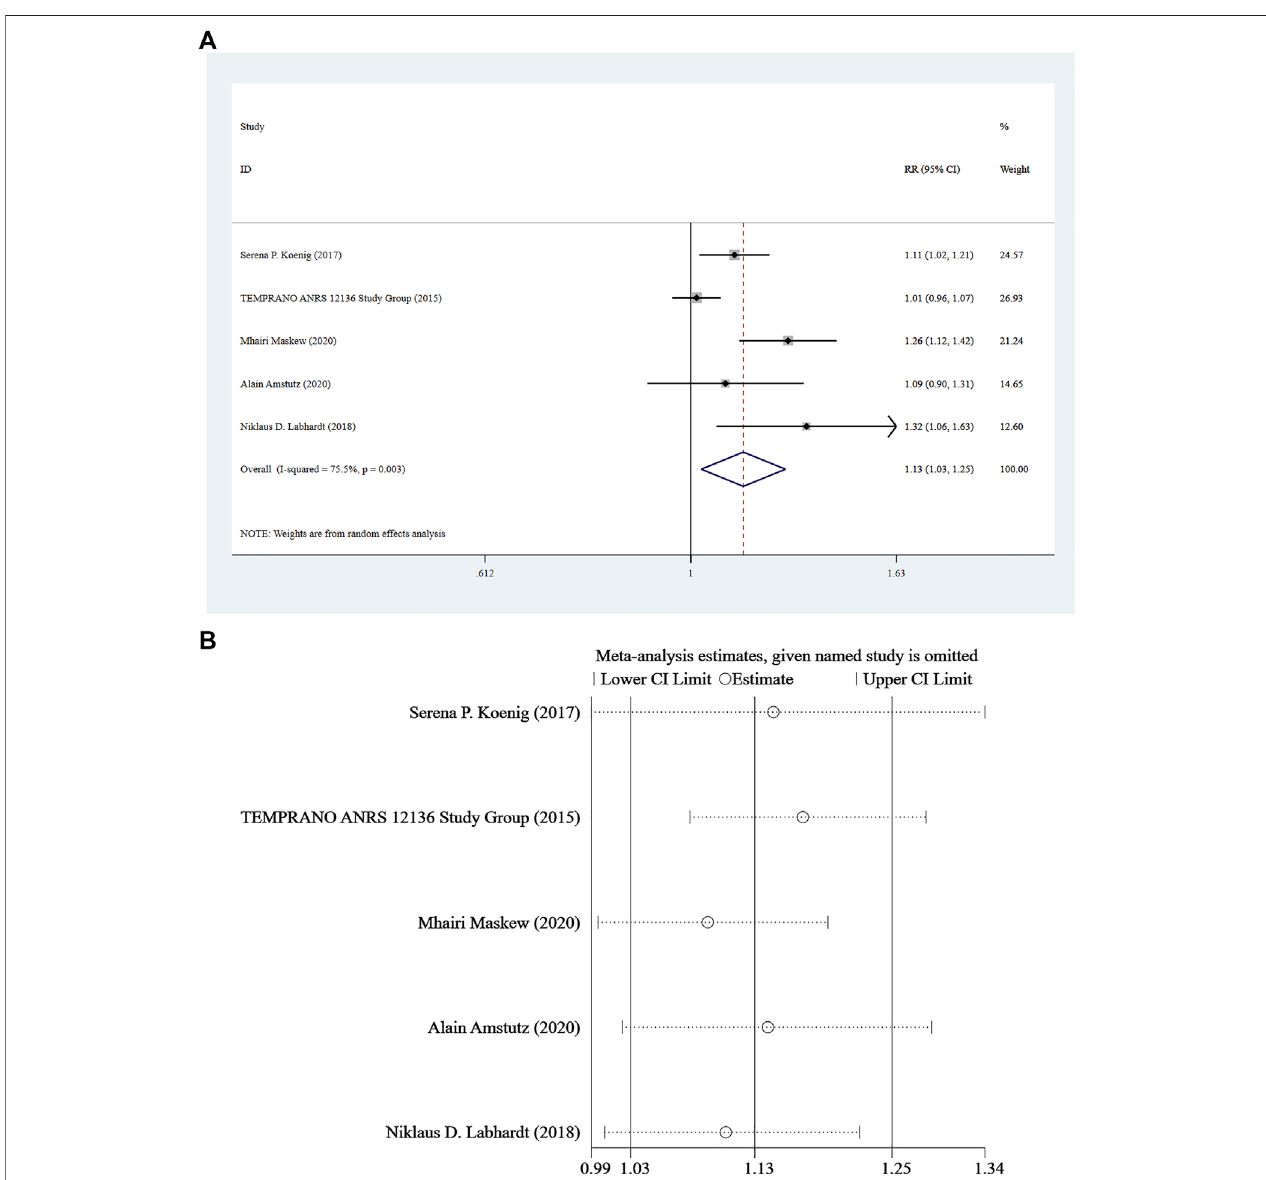
FIGURE 4 | (A) Forest plot for Meta-analysis of continuing care statistics chart. (B) Sensitivity analysis of continuing care statistics chart (After removing the literatures one by one, the circles of each study were within the two edges, indicating that the conclusions of this meta-analysis were stable and reliable).